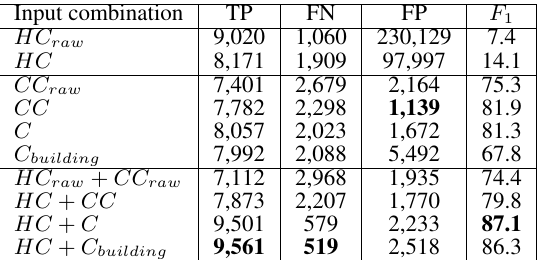
Table 3. Amount of TP, FN and FP pixels as well as F1-scores [%] calculated on raster-level for different inputs at τ = 0 . 5 for the ALS-DIM test set. Best results are marked